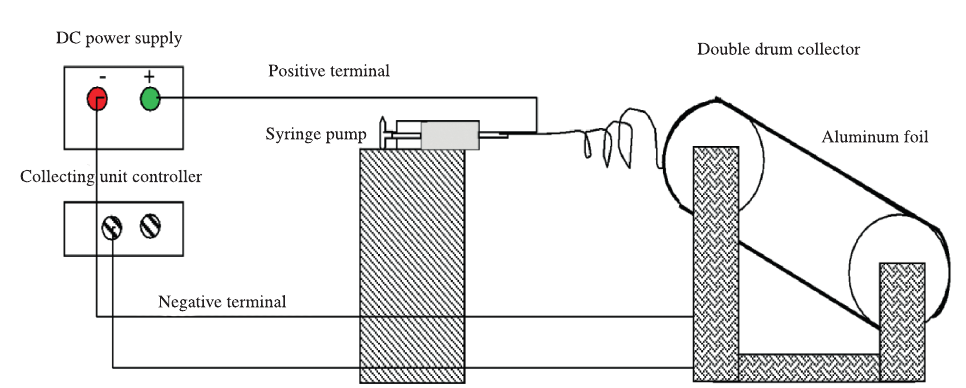
Figure 1. A block diagram of an indigenously designed electrospinning set